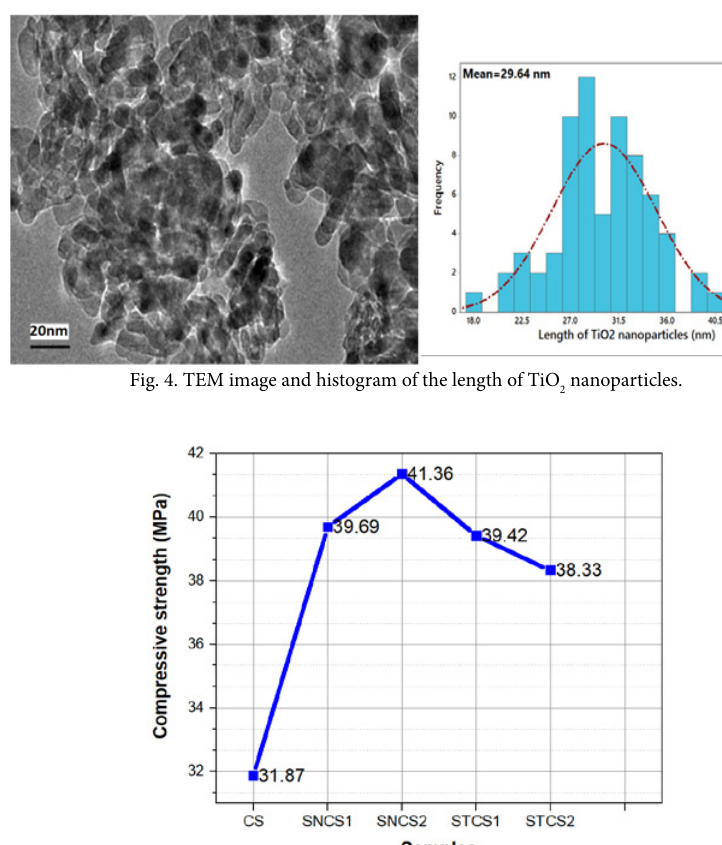
Fig. 5. Variations in compressive strength of cement-based composite. Figure 5. Variations in compressive strength of cement-based composite.